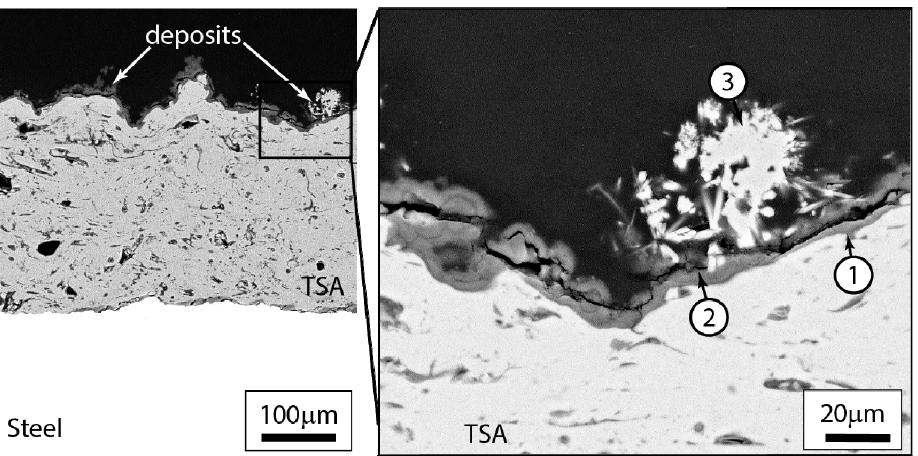
Figure 11. Micrograph of cross-section of TSA on X80 polarised to − 1100 mV (Ag/AgCl/saturated KCl) in synthetic seawater for 30 days.